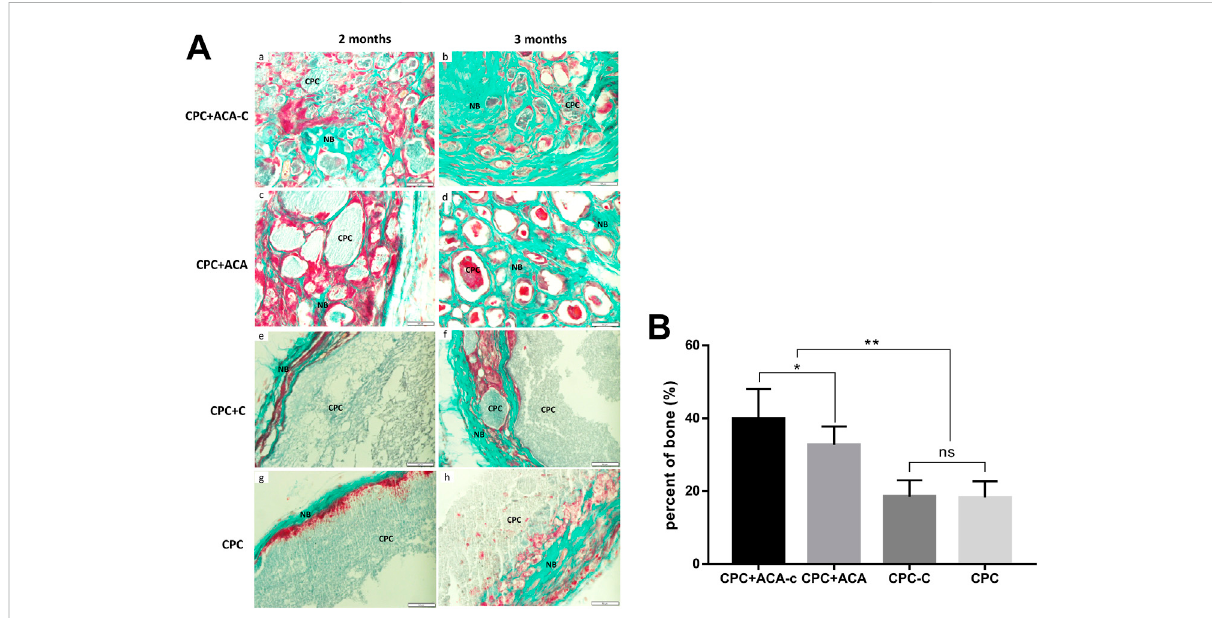
FIGURE 8 (A) Goldner ’ s trichrome-stained tissue sections of the CPC + ACA-C, CPC + ACA, CPC + C and CPC groups after 2 and 3 months of implantation, bar = 50 μ m; (B) Newly formed bone areas of Goldner ’ s trichrome-stained tissue sections after 3 months (NB: newly formed bone; CPC: implanted samples; *: p < 0.05, **: p <